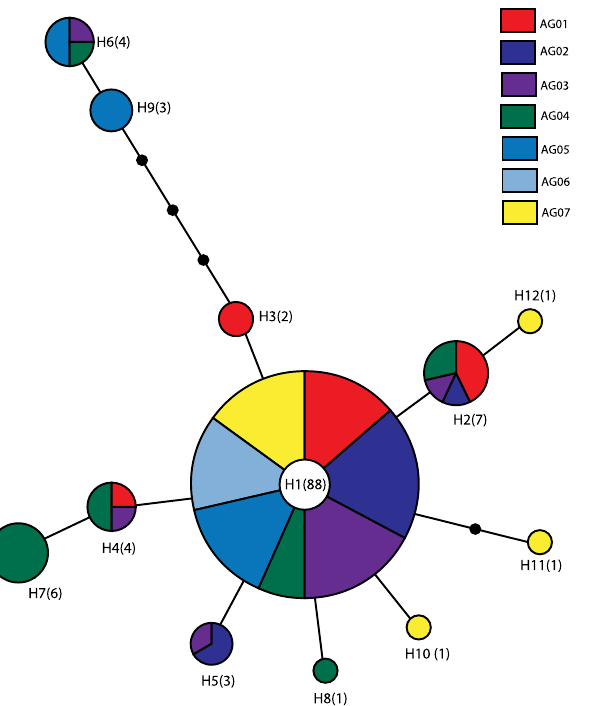
Figure 4. Haplotype network of COI sequences from seven populations of Asynapta groverae . The area of the circle is proportional to the individual numbers of the respective haplotype. Numbers shown in parentheses represent the number of individuals belonging to a haplotype. Each line in the network represents a single mutational step between haplotypes irrespective of its length. Different colors denote different